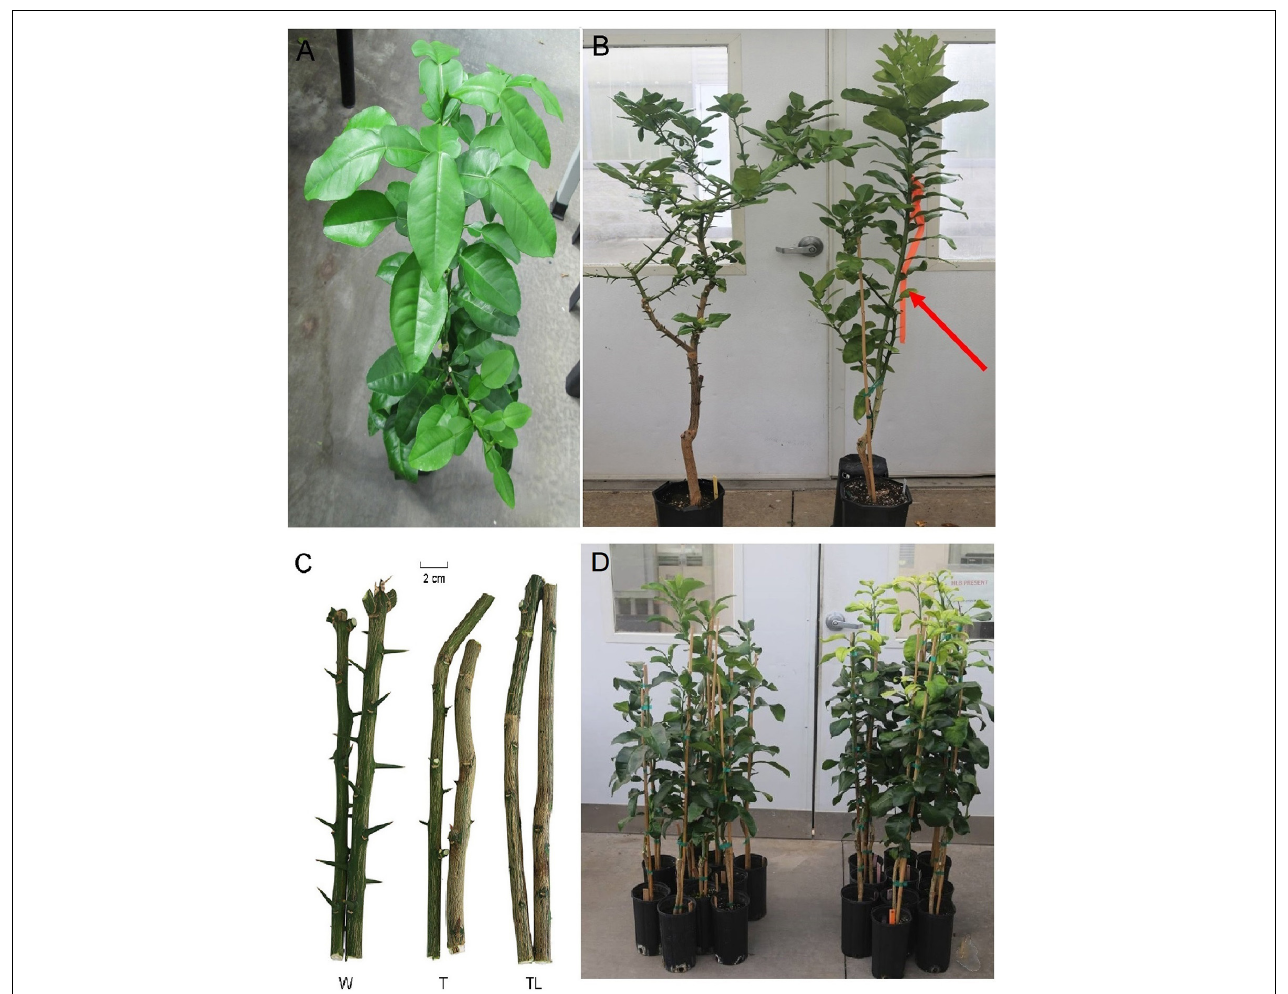
FIGURE 1 | Pummelo thornless bud-sport selection and evaluation. (A) Asymptomatic HLB-tolerant Mato Buntan seedling (wild type W) with CT = 24.5 1 year after Las inoculation. (B) Comparison of the growth of W (left) and thornless bud-sport (red arrow). (C) The branches of W, T, and TL. (D) The HLB-tolerant mutants (TL and T) in the left show growth retardation, while the susceptible grapefruit plants on the right showed typical yellow shoot symptoms 12 months after inoculation with an aggressive Las